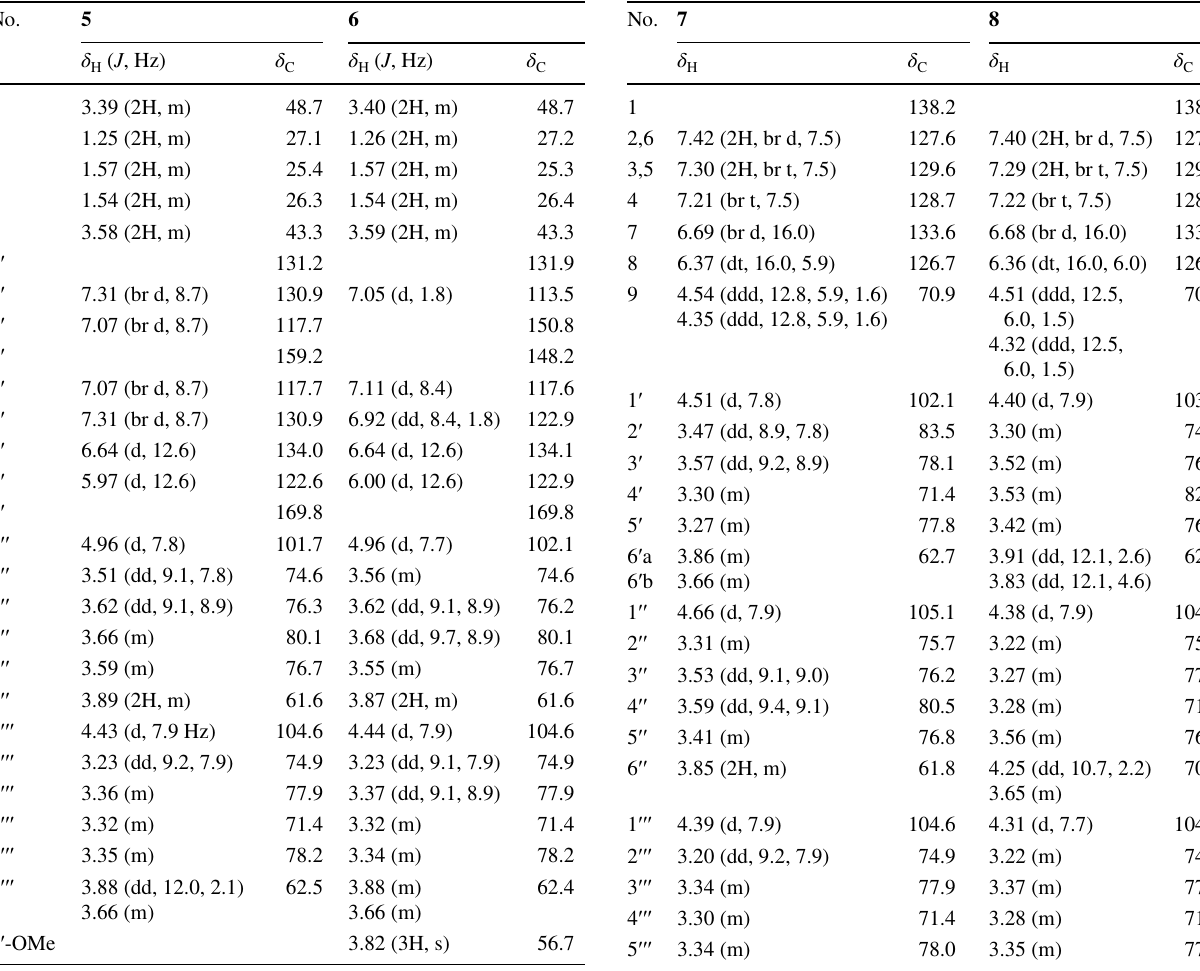
Table 4 1 H (800 MHz) and 13 C NMR (201 MHz) data of 7 and 8